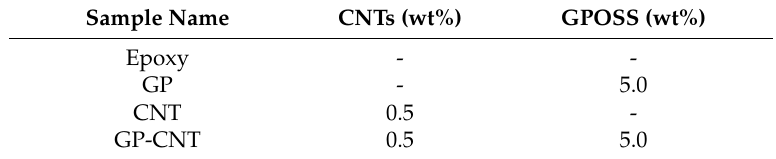
Figure 2. Curing cycle.